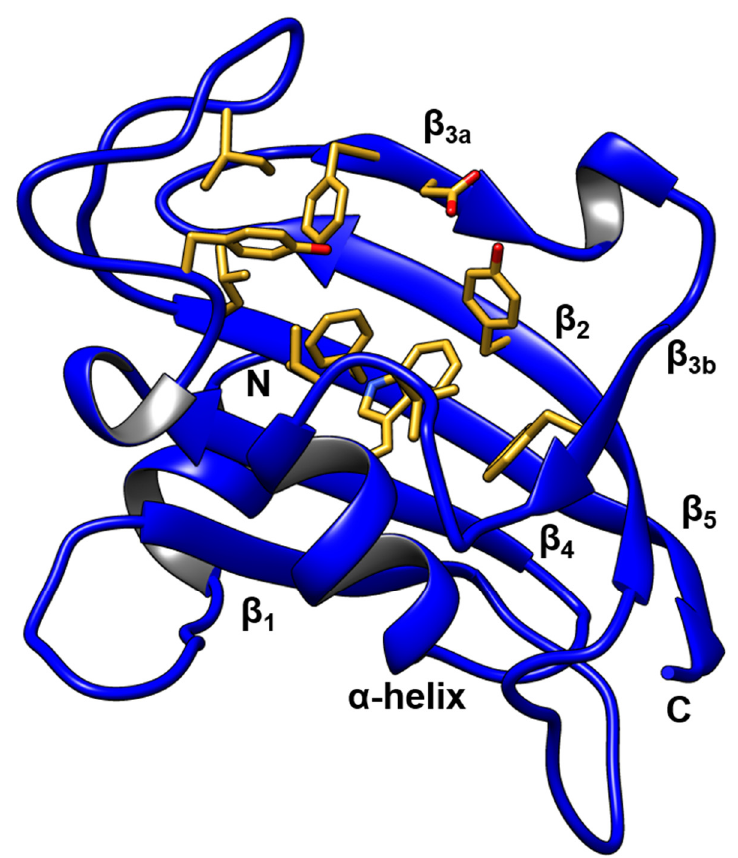
Figure 2. Structure of the FKBP51 FK1 domain. Conserved binding pocket amino acids are depicted in yellow (PDB-ID: 3O5E).